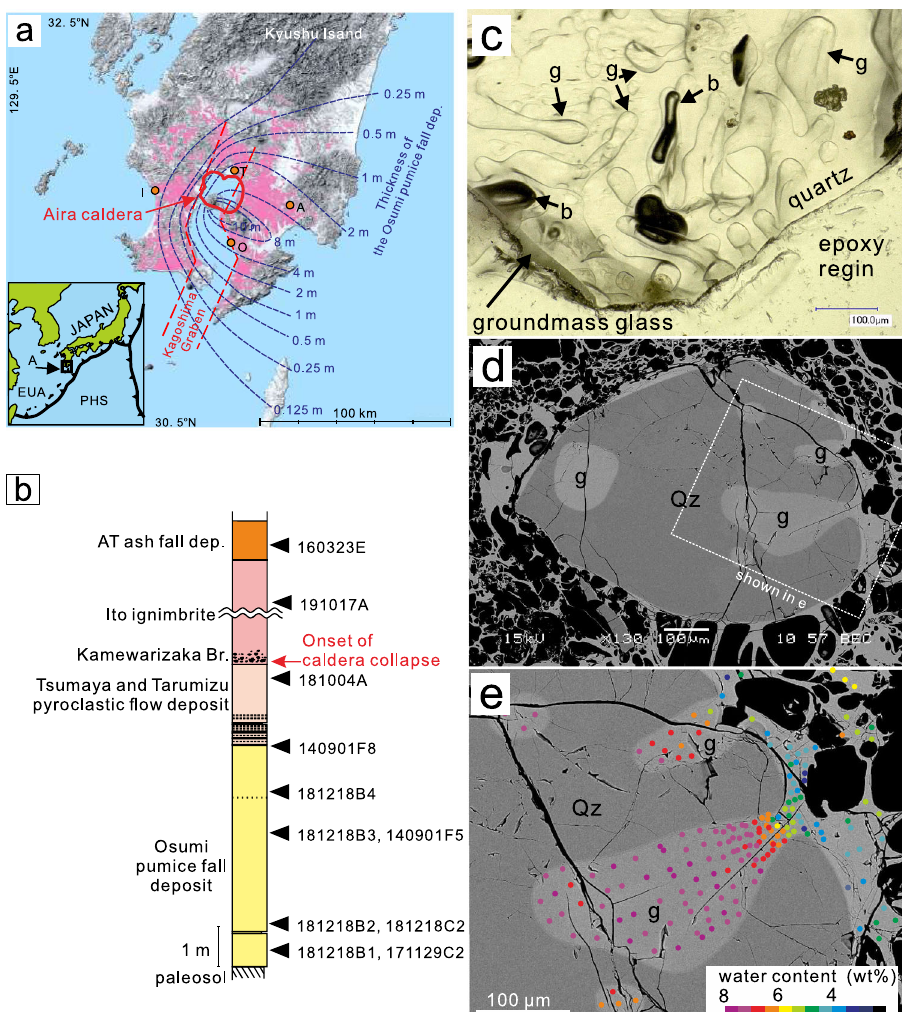
Fig. 1 Overview of AT-eruption products. a Distribution of products of the AT eruption. Inset shows the location of the Aira caldera. The solid red line indicates the topographic rim of the Aira caldera, broken blue lines are the isopach lines that represent the thickness of the Osumi pumice fall deposit, and the pink-colored area represents the distribution area of Ito ignimbrite. Orange circles with labels “ O ” , “ T ” , “ I ” , and “ A ” show the sampling locations of the Osumi pumice deposit, Tsumaya pyroclastic fl ow deposit, Ito ignimbrite, and the AT ash fall deposit, respectively. b Schematic stratigraphy of the eruptive products of the AT eruption showing sampling depths. c Optical microscopic image of glass embayments in a quartz phenocryst of the Osumi pumice